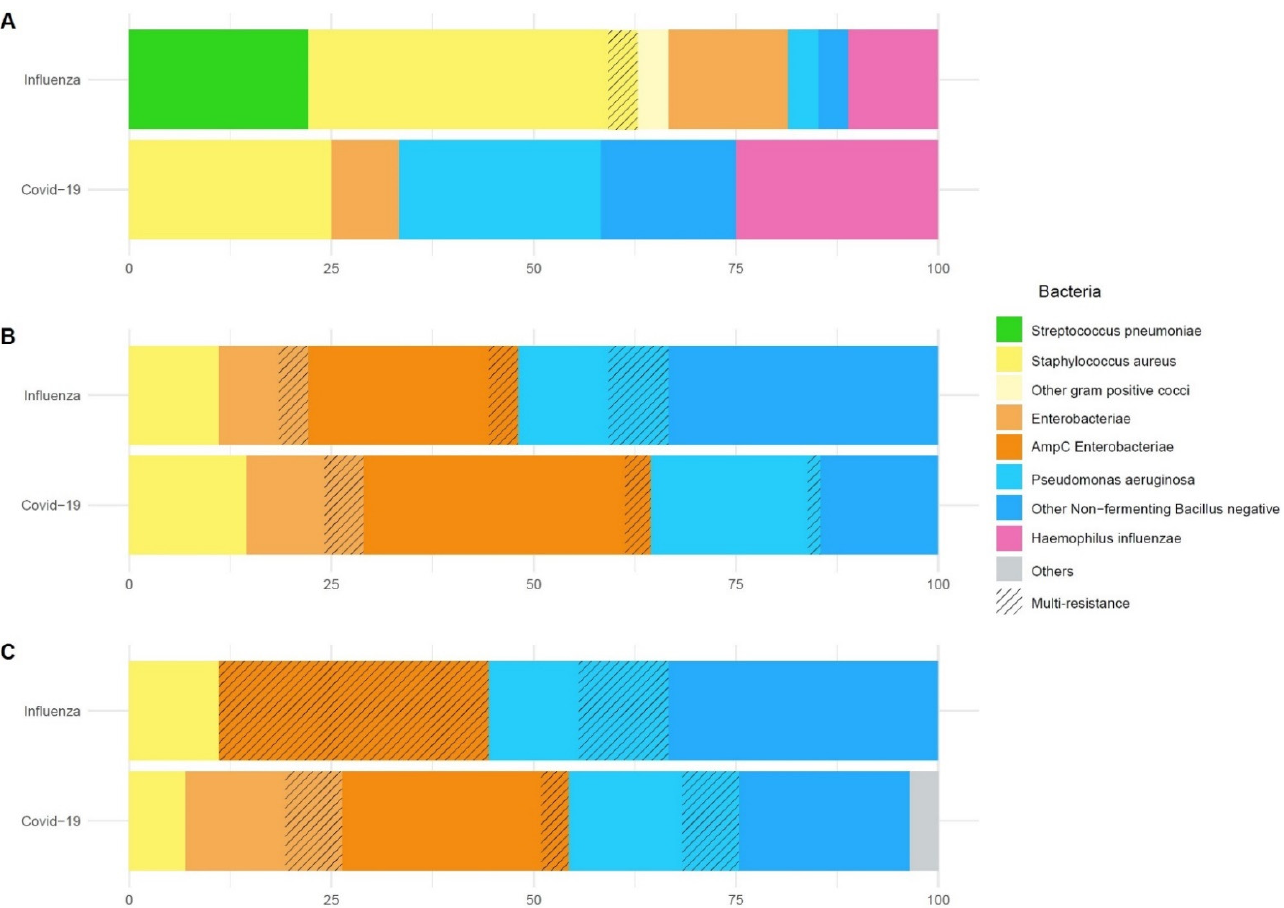
Figure 3. Microbiological findings. Repartition of bacterial strains in percentage of all species isolated. From the top down: ( A ) co-infection at baseline, ( B ) first VAP, ( C ) second and third VAP. For each pathogen group, proportion of multi-drug resistant bacteria appears striped. Table 3. Microbiological findings.